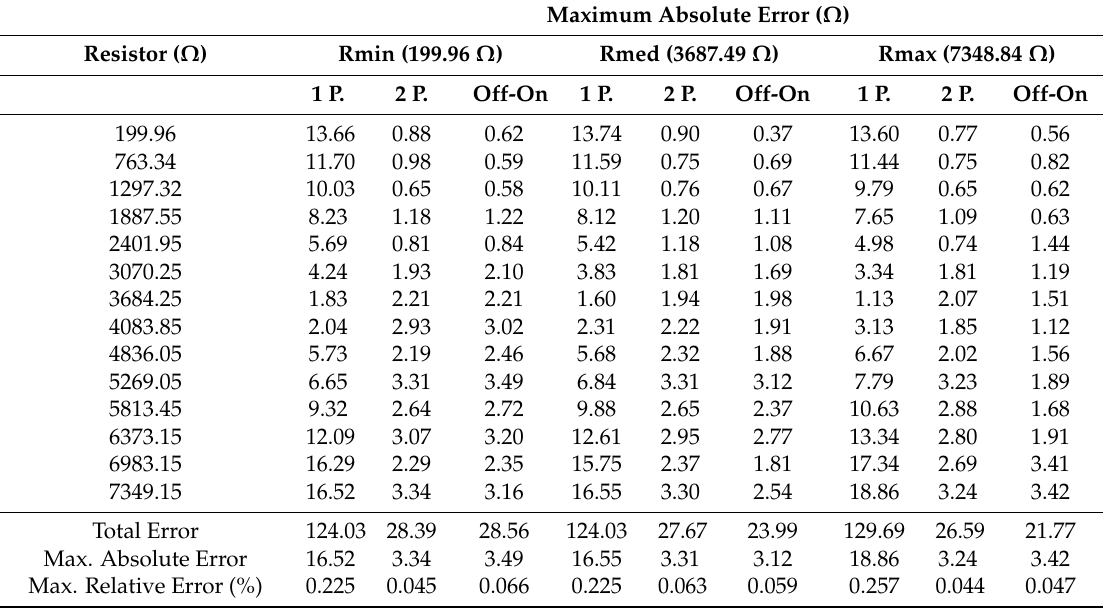
Table 3. Accuracy data for different calibration techniques with a 47 nF capacitor and Q =